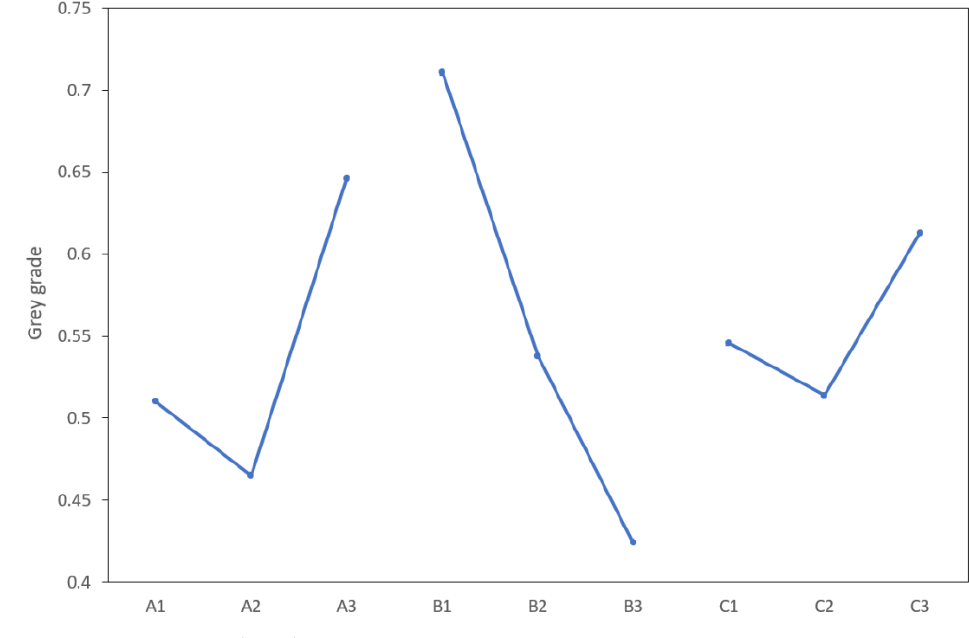
Figure 3. Grey rational grades. Table 6. ANOVA study of grey rational